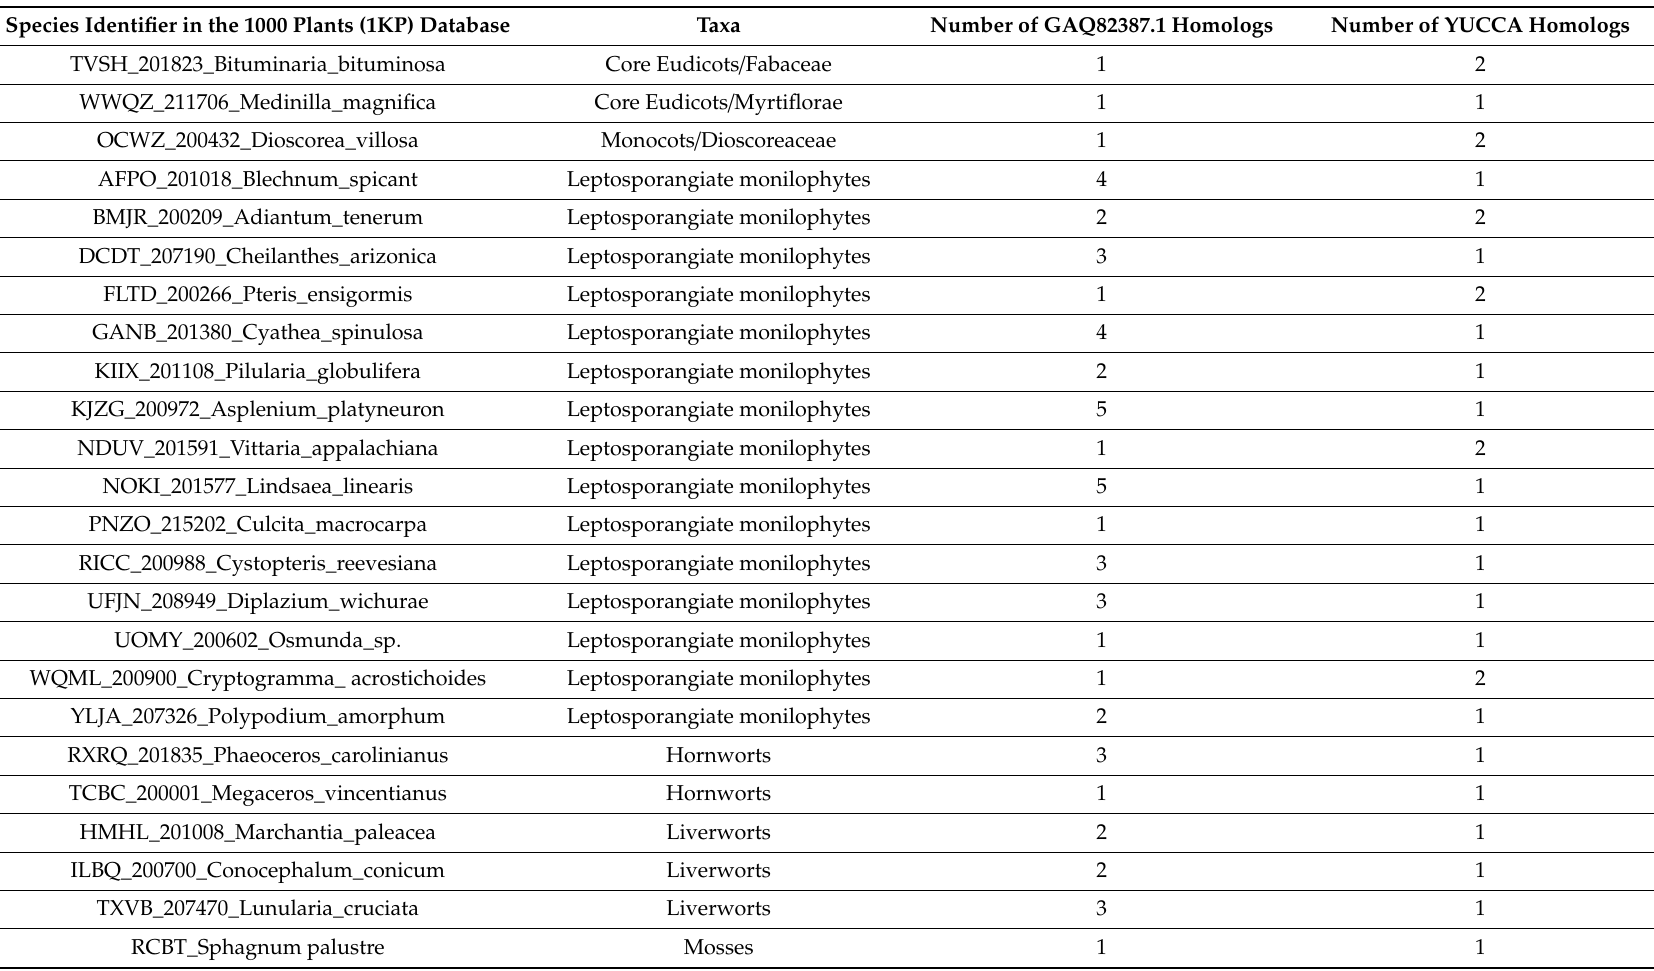
Table 3. The plant species with detected homologs of both K. nitens GAQ82387.1 and A. thaliana YUC2 AT4G13260 in the 1KP database. Species Identifier in the 1000 Plants (1KP)